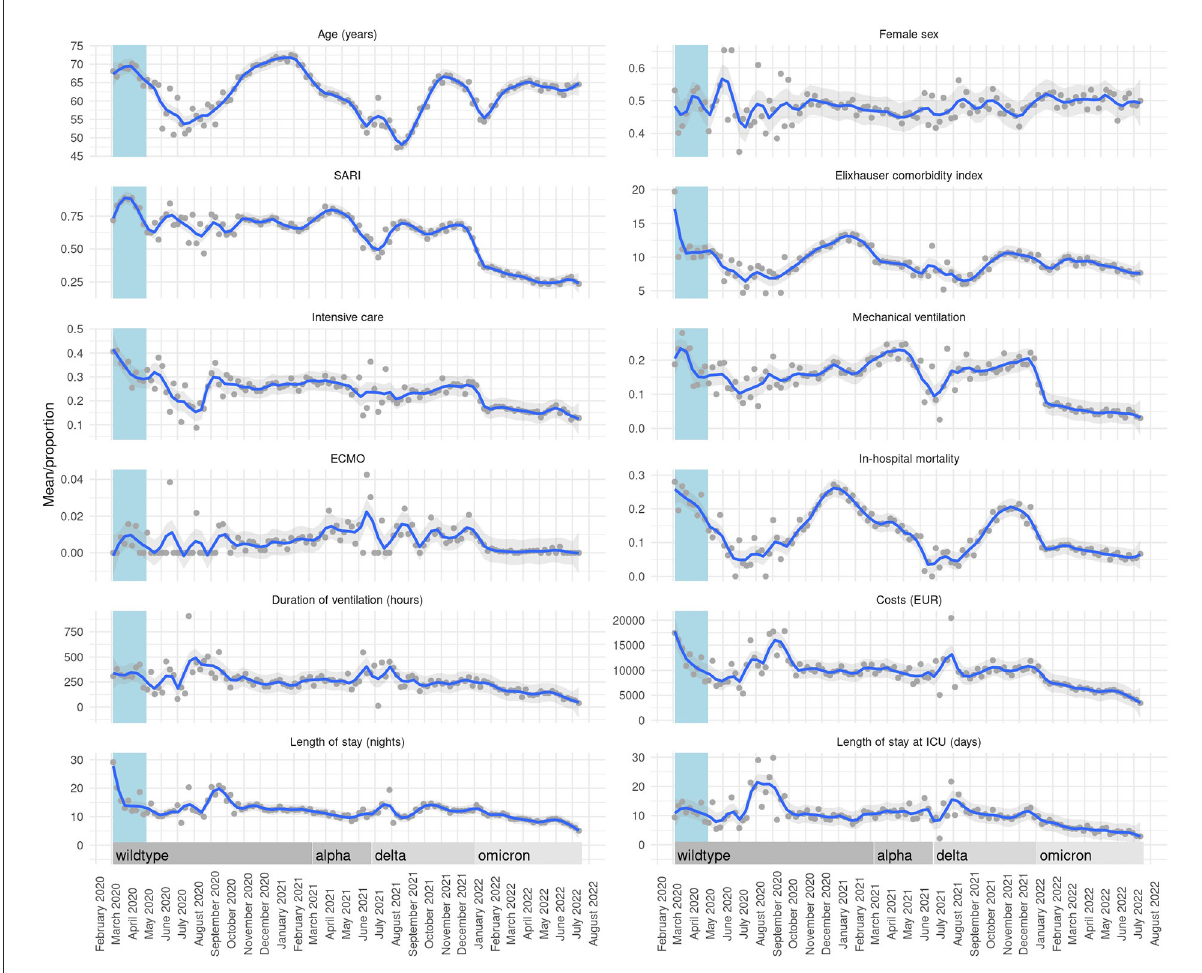
FIGURE2 Temporal trends presented as weekly means/proportions per variable. Locally estimated scatterplot smoothing curves with 95% CIs for weekly means/proportions as a function of admission